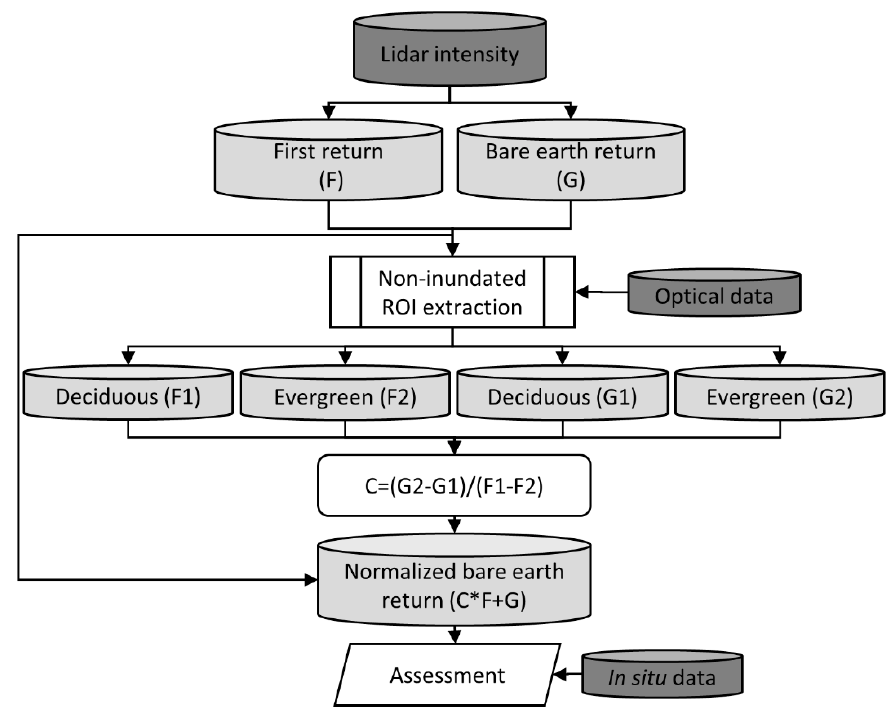
Figure 2. A graphical representation of the normalization process, which corrects for the influence of evergreen canopy on bare earth lidar intensity data. Abbreviations used in the equations are provided earlier within the flow chart.